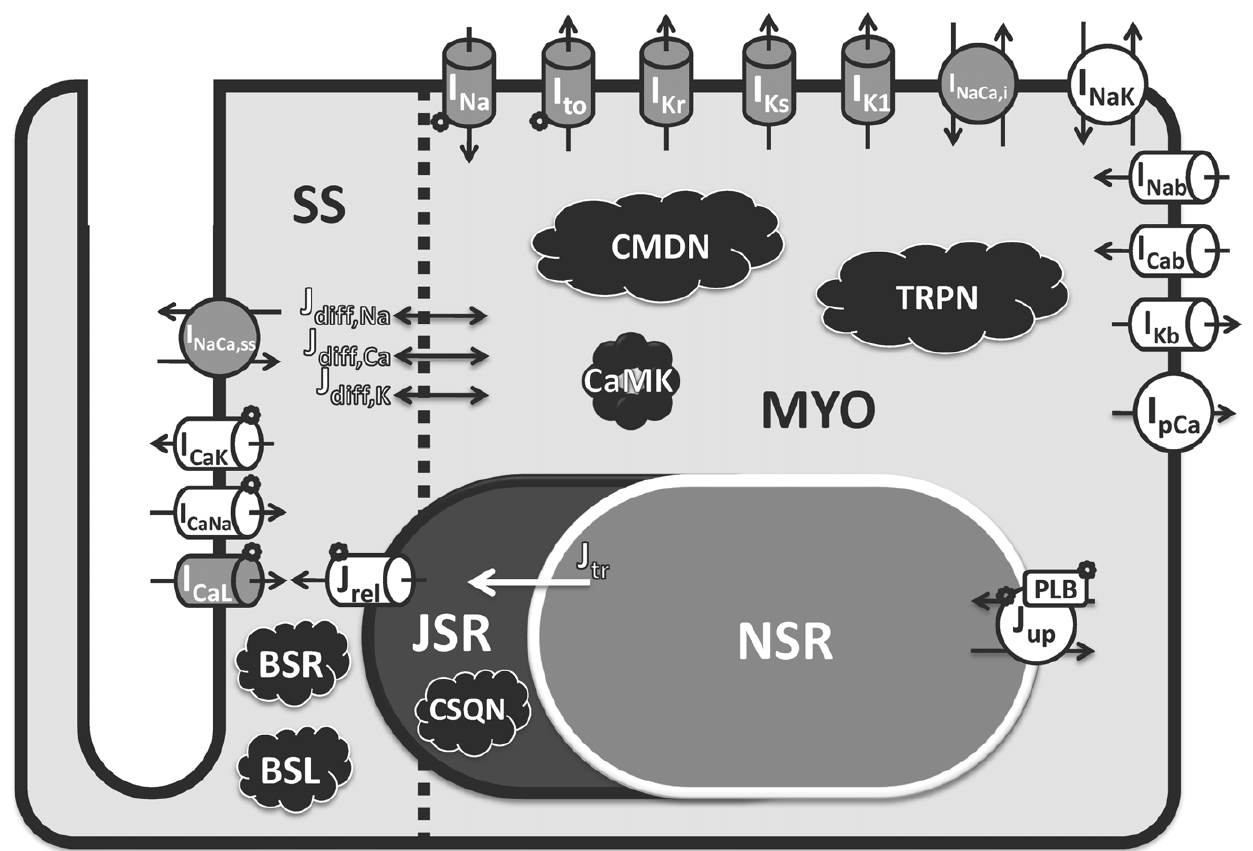
Figure 5. Schematic diagram of human ventricular myocyte model. Formulations for all currents and fluxes were based either directly (gray) or indirectly (white) on undiseased or nonfailing human experimental data. Model includes four compartments: 1) bulk myoplasm (myo), 2) junctional sarcoplasmic reticulum (JSR), 3) network sarcoplasmic reticulum (NSR), and 4) subspace (SS), representing the space near the T-tubules. Currents into the myoplasm: Na + current (I Na ; representing both fast and late components), transient outward K + current (I to ), rapid delayed rectifier K + current (I Kr ), slow delayed rectifier K + current (I Ks ), inward rectifier K + current (I K1 ), 80% of Na + /Ca 2 + exchange current (I NaCa,i ), Na + /K + pump current (I NaK ), background currents